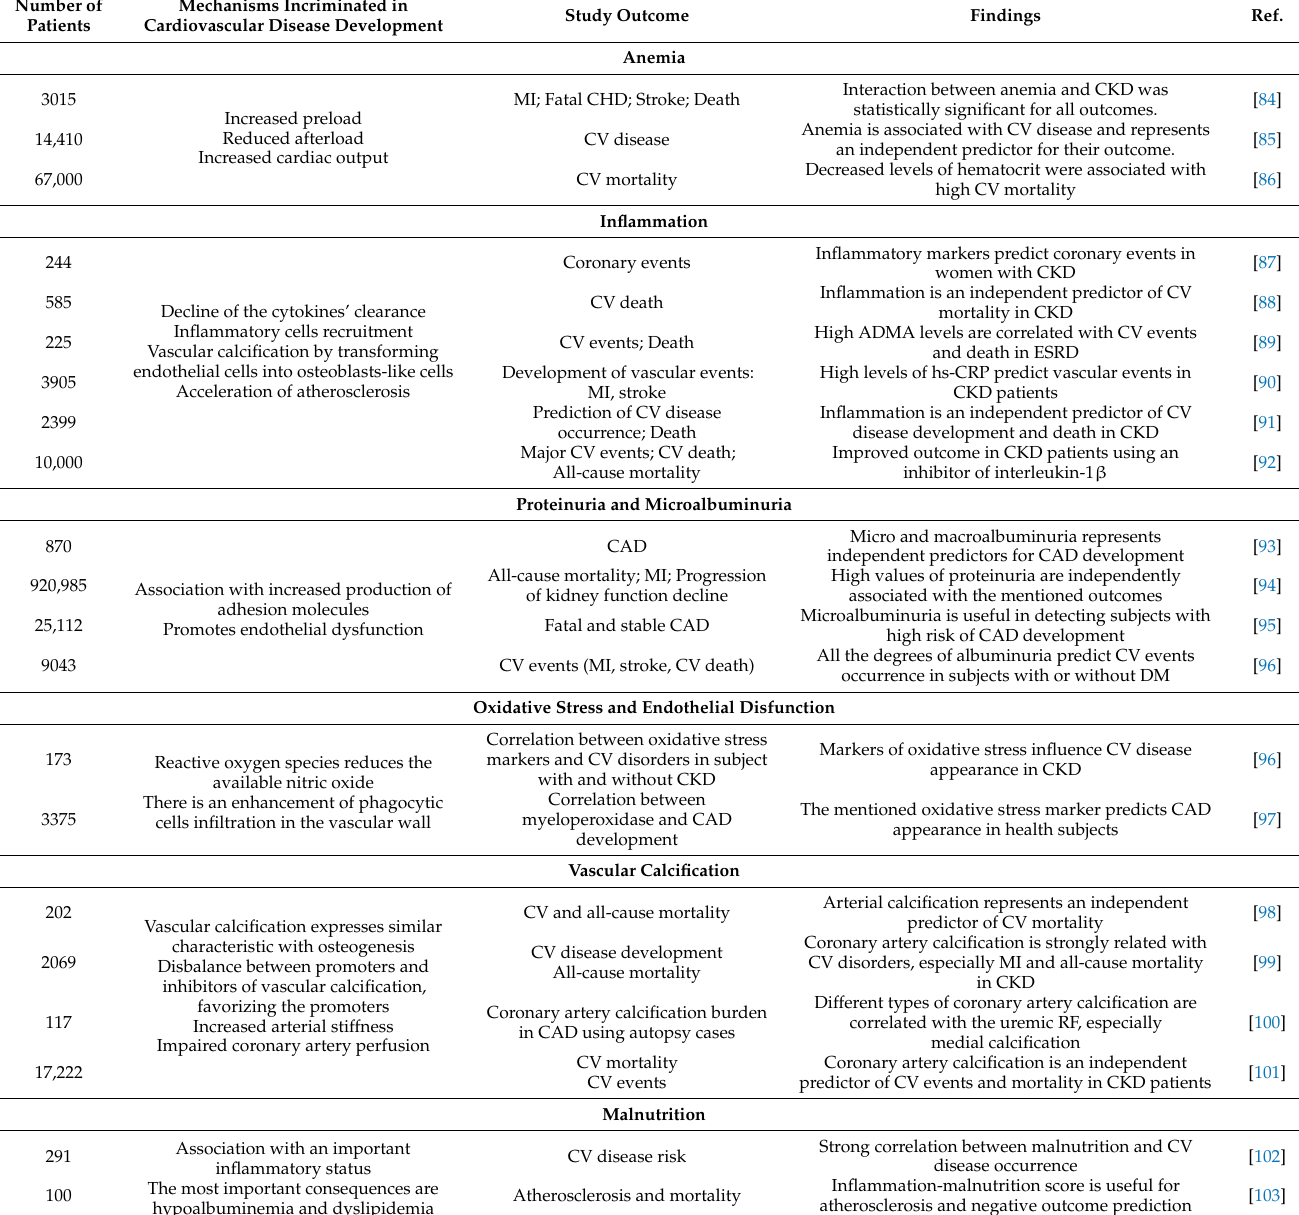
Table 1. Main studies revealing the importance of uremic risk factors in cardiovascular disease pathogenesis. Number of Mechanisms Incriminated in Patients Cardiovascular Disease